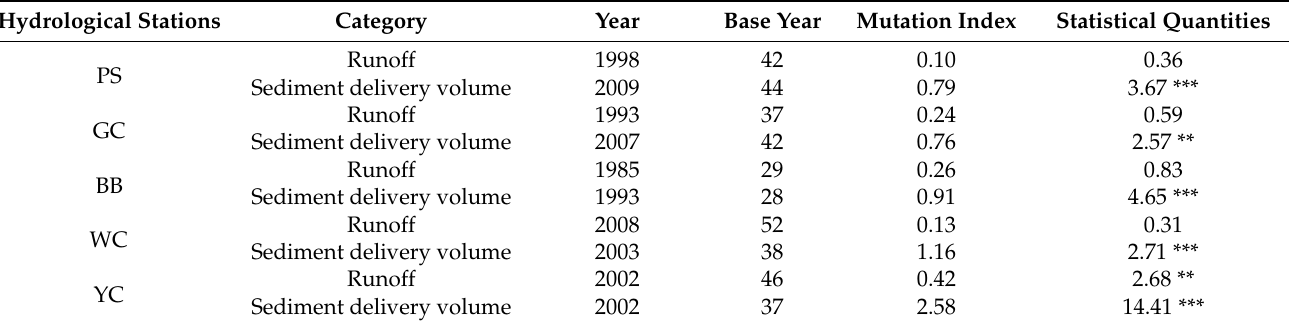
Table 3. The t -test of mean of runoff and sediment.